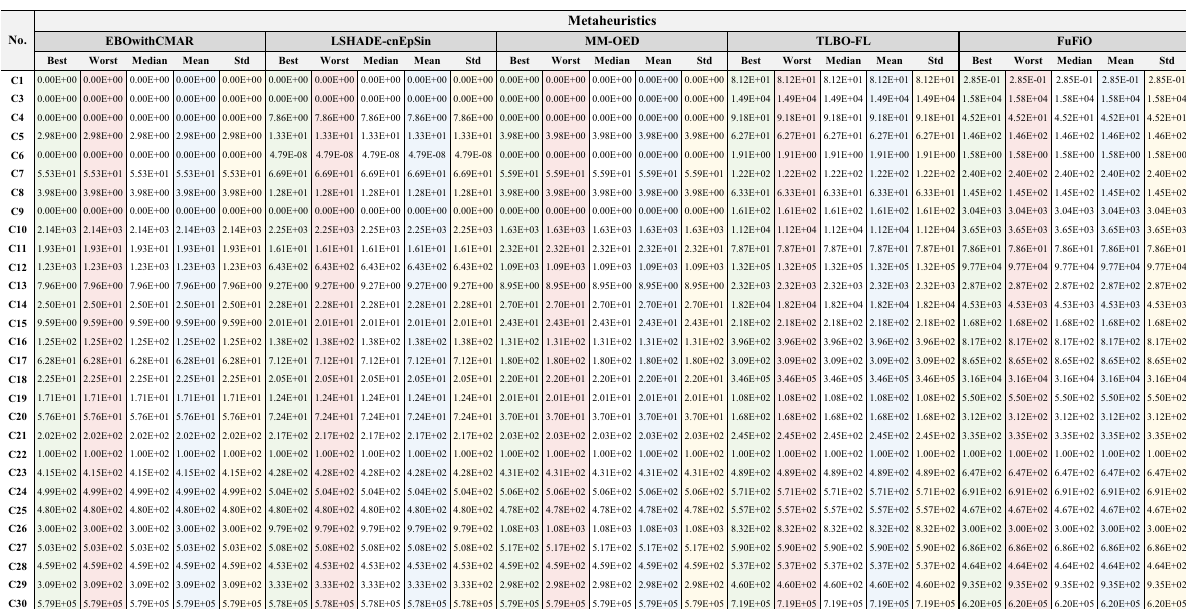
Table 15. Statistical results of different algorithms for the 50-dimensional CEC-2017